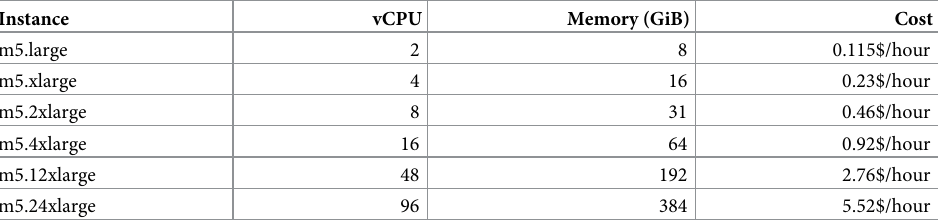
Table 1. AWS instances used in our benchmarks. Prices for EU (Frankfurt) Oct.